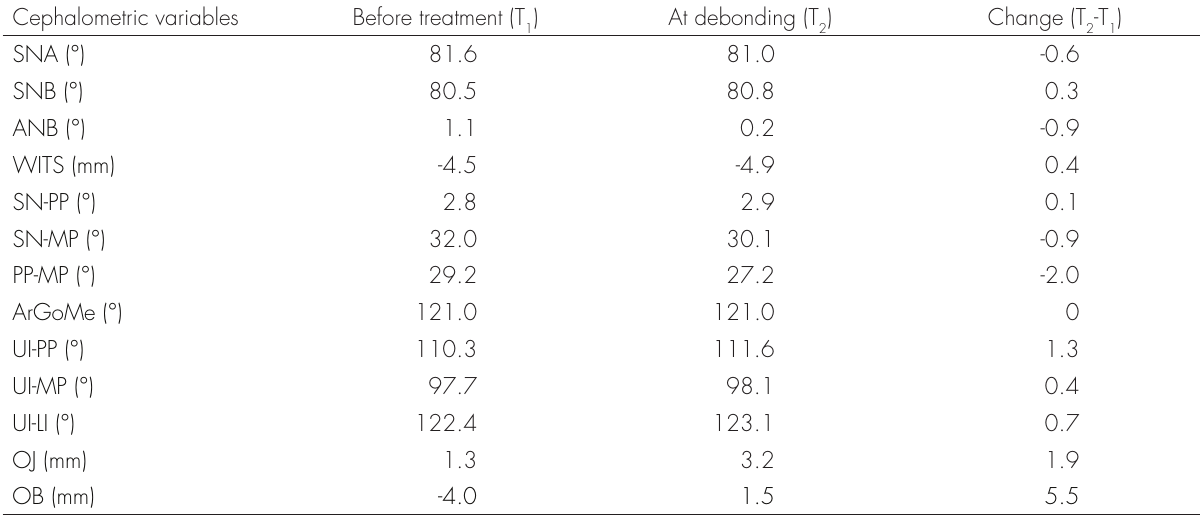
SNA, Angle Sella-Nasion-A point; SNB, Angle Sella-Nasion-B point; ANB, Difference of SNB and SNA; WITS, Linear difference between B point and A point on functional occlusal place; SN-PP, Angle Sella-Nasion line to Palatal plane; SN-MP, Angle Sella-Nasion line to Mandibular plane; PP-MP, Angle between Palatal and Mandibular planes; ArGoMe, Angle between Articulare-Gonion-Menton; UI-PP, Angle between Upper incisor long axis and Palatal plane; LI-MP, Angle between Lower incisor long axis and Mandibular plane; UI-LI, Angle between long axes of Upper and Lower incisor; OJ, Overjet; OB,